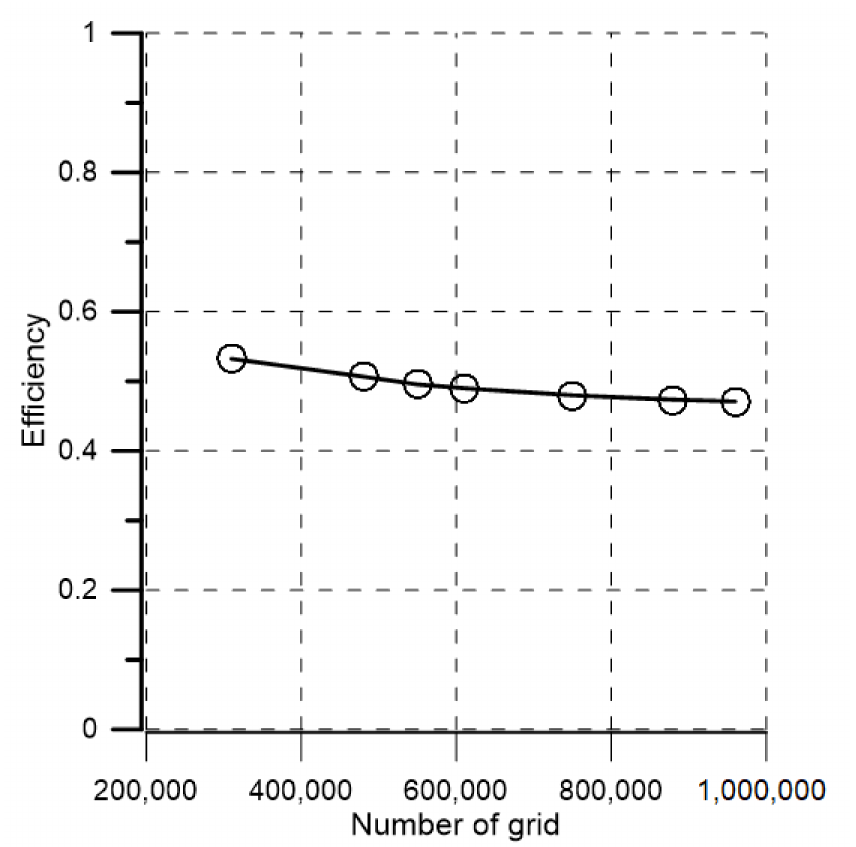
( β = 0 ◦ ) micromixer at Re = 10. Figure 4. Efficiency at the output of ( Y − U ) 0 ◦ Figure 5 shows the grid division of ( Y − U ) micromixer at β = 0 ◦ . Predominantly 0 ◦ quad meshes were created as shown and the element size was always 25 µ m. No sweep bias was employed to generate uniform mesh under the sweep method.